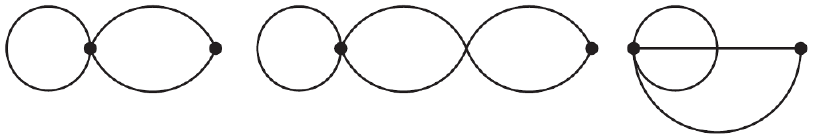
Figure 4 . The (cid:30) 4 (cid:0) (cid:30) 2 correlator up to order ^ g . The full dots represent the composite operator